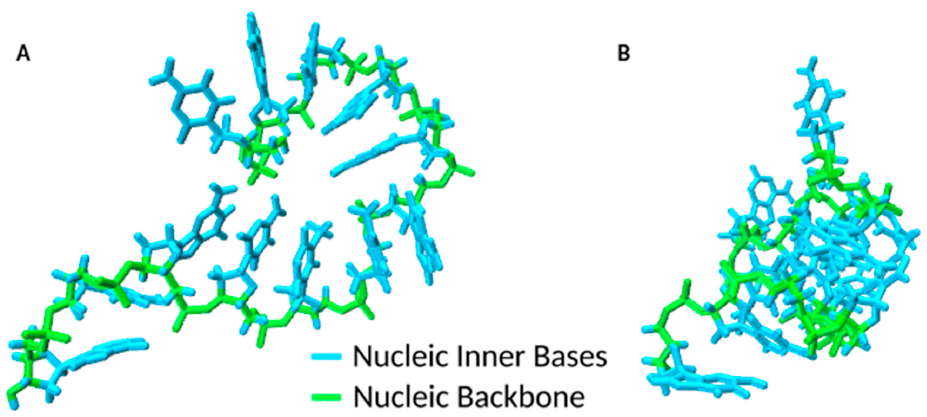
Figure 3. Representative conformations of ssDNA during the 300 ns simulation time. ( A ) conformation anchored to the GO surface by hydrogen bonds formed by a terminal nucleobase; ( B ) condensed conformation anchored to the GO surface by π – π stacking formed by a terminal nucleobase.